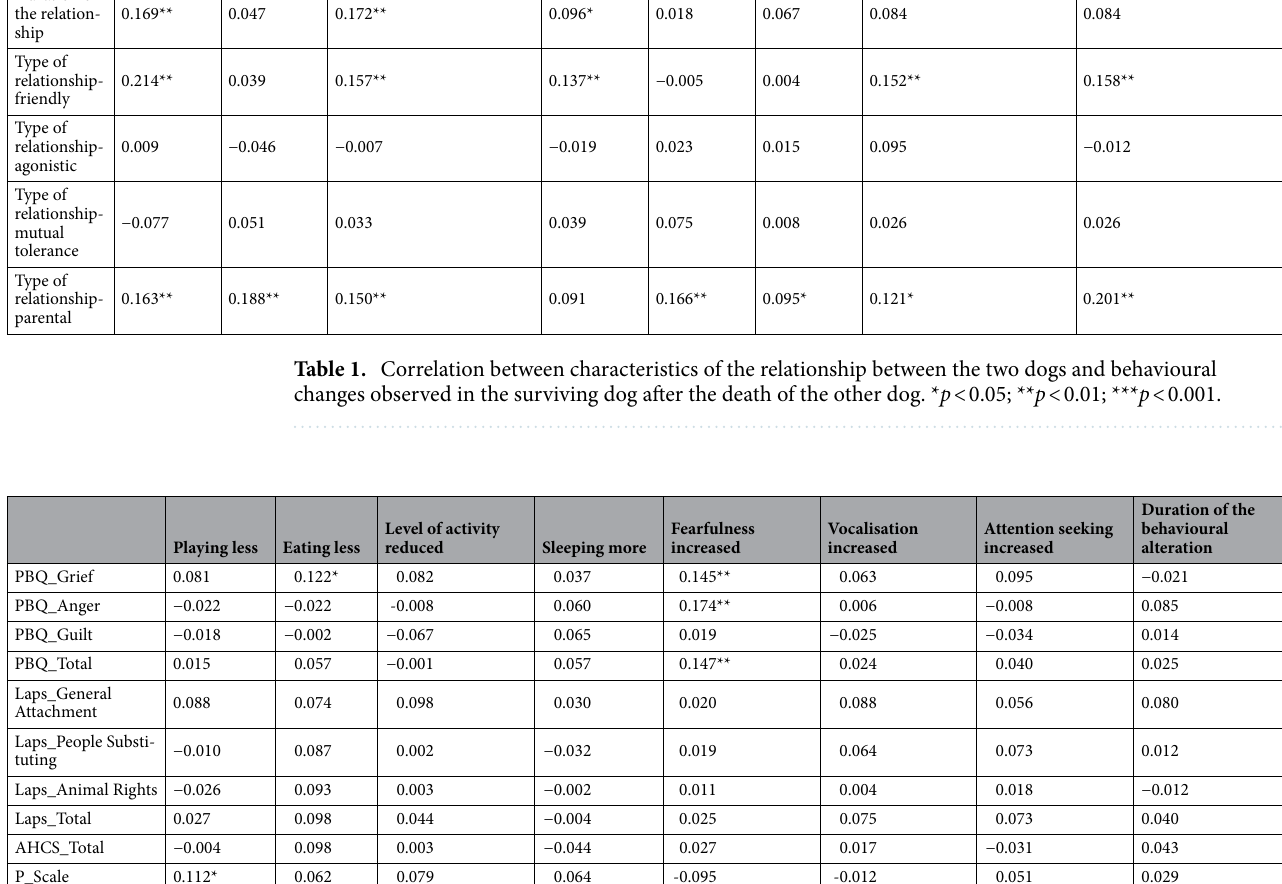
Table 2. Correlation between constructs related to owner and behavioural change observed in the surviving dog after the death of the other dog. * p < 0.05; ** p < 0.01; *** p < 0.001.